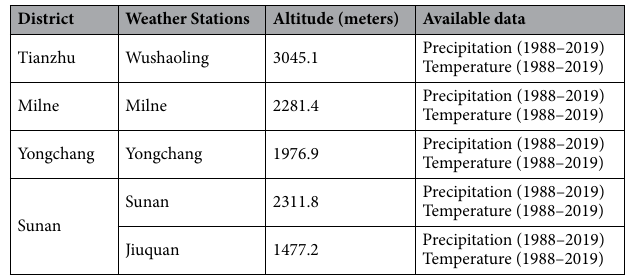
Table 1. Weather stations selected for the purpose of the